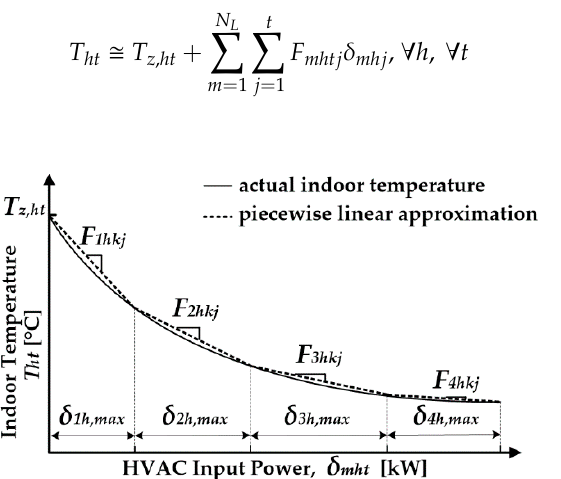
Figure 3. Estimation of the indoor temperature as a function of HVAC input power using piecewise linear approximation.